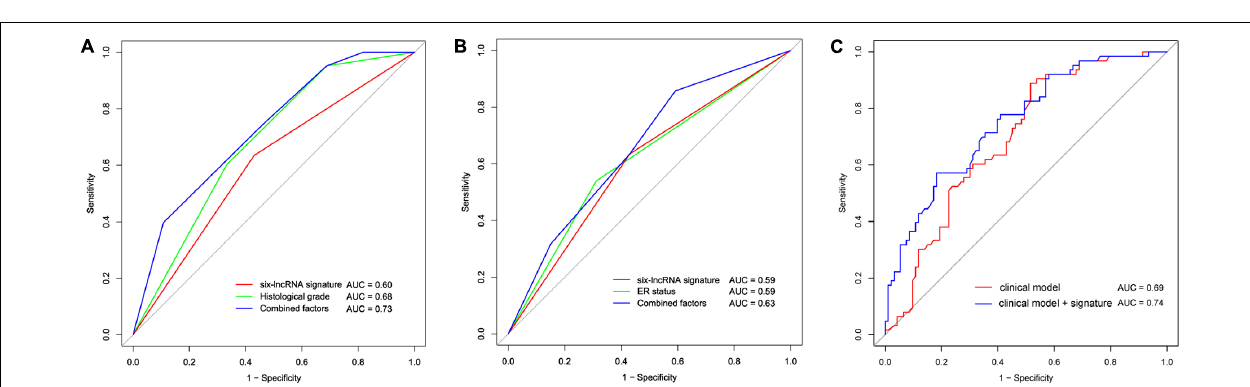
FIGURE 6 | Comparison of sensitivity and specificity for survival prediction by the six-lncRNA signature, histological grade, and ER status. (A) The receiver operating characteristics (ROC) curves of the six-lncRNA signature, histological grade, and the combination of the two factors. (B) The ROC curves of the six-lncRNA signature, ER status, and the combination of the two factors. (C) The ROC curves of the clinical model and the clinical model combined with the six-lncRNA signature. AUC, the area under the